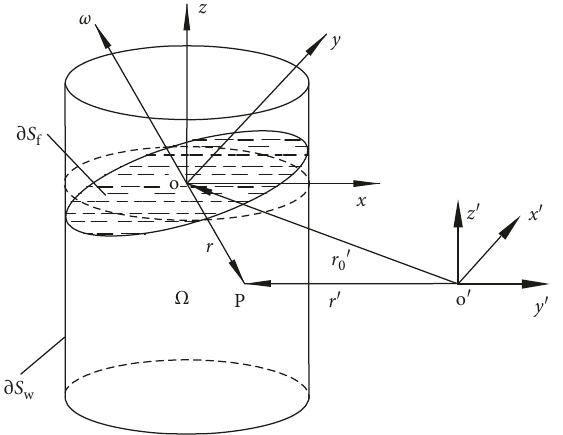
Figure 1: Moving rigid tank partially filled with